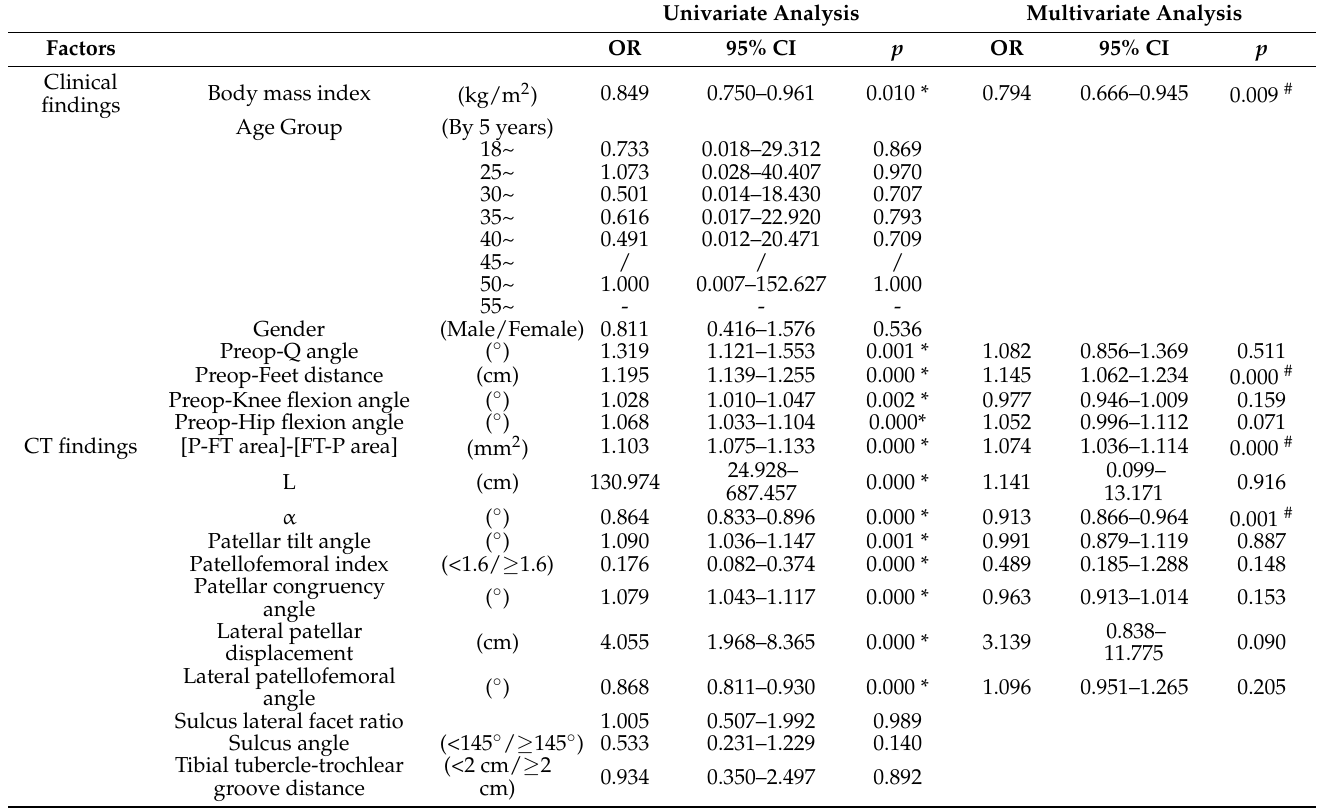
Table 3. Factors associated with international classification of gluteal muscle contracture (Ye et al.) in the ordinal logistic regression analysis.